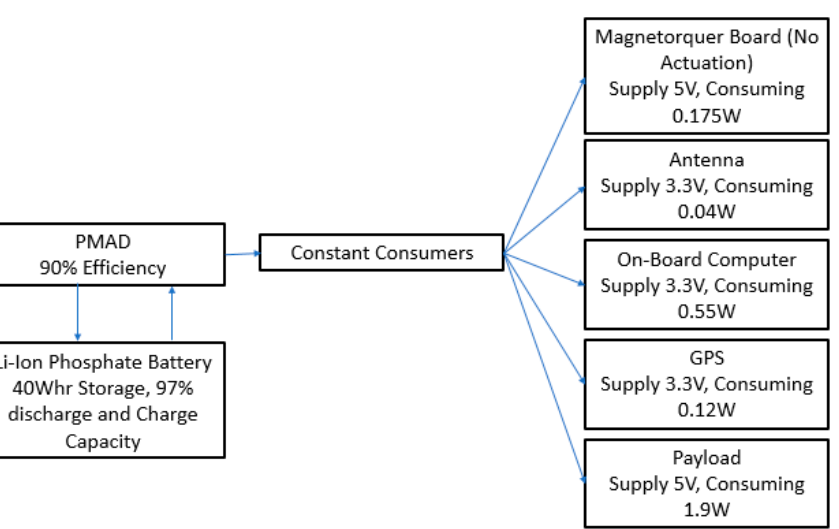
Figure 42. Constant Consumers Cold Case Block Diagram.